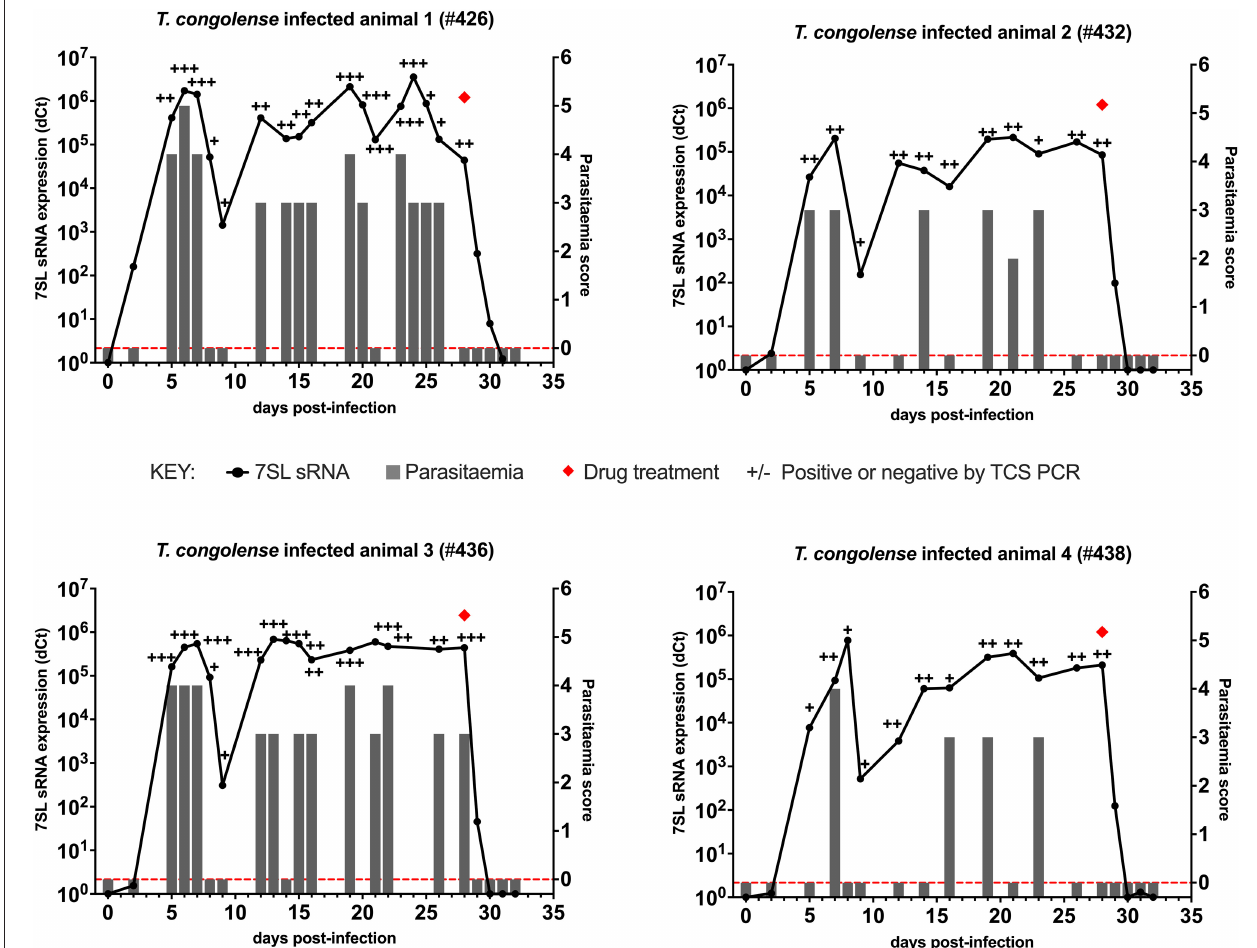
FIGURE 2 | Comparison of detection by buffy coat microscopy, TCS PCR and 7SL sRNA RT-qPCR in T. congolense infected calves. Four calves (Holstein-Friesian, approximately 4–6 months old) were infected with T. congolense IL3000 (day 0) and monitored for 32 days. On day 28, calves were treated with diminazene aceturate, indicated by a red diamond. Parasitaemia (right y axis) was determined on average every 2 days by the BCT and is indicated by gray bars. Approximate parasitaemia equivalences (trypanosomes/mL) of the score used: 1 = 1 × 10 2 ; 2 = 1 × 10 3 ; 3 = 5 × 10 3 -5 × 10 4 ; 4 = 1 × 10 4 -5 × 10 5 ; 5 = 5 × 10 5 -5 × 10 6 ; 6 = > 5 × 10 6 . Gray bars measuring 0 indicate time points in which parasitaemia was measured but no parasites were detected (0 on y axis is shown by red dotted line). Relative expression (dCt) of 7SL sRNA by RT-qPCR (left y axis) is shown with a black line and was calculated by normalizing to an uninfected control animal. TCS PCR results are shown by plus ( + ) or minus (–) signs indicating the presence or absence of the expected band on an agarose gel,